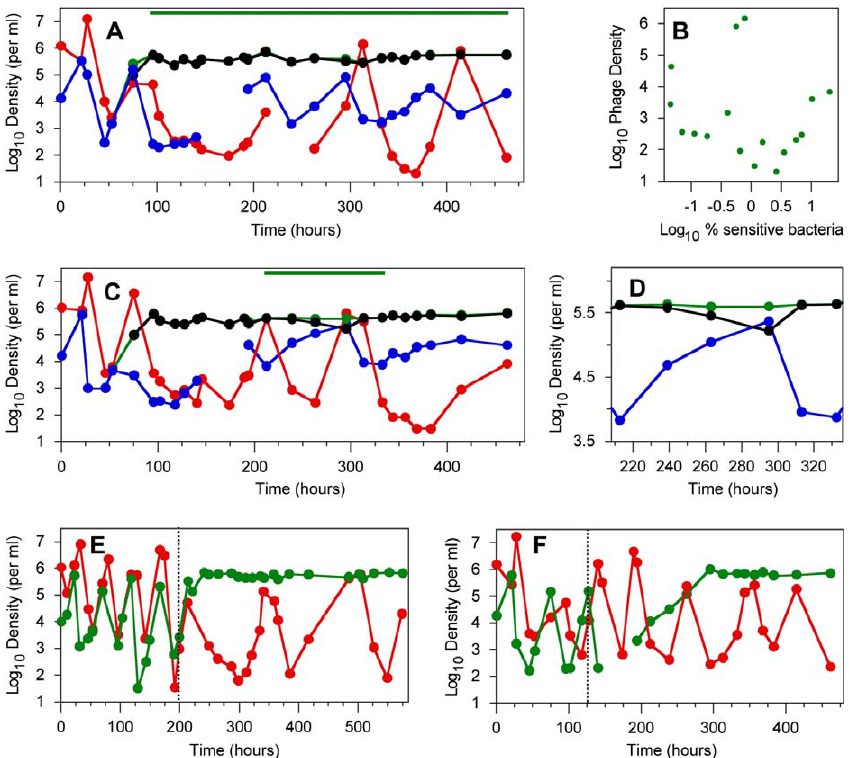
Figure 6. Experimentally Observed Cryptic Cycles in Bacteria–Phage Chemostats (A) Results from [32] showing densities of phage (red), sensitive bacteria (blue), resistant bacteria (black), and total bacteria (green, mostly hidden by black). Resistant bacteria with a neutral genetic marker were introduced ’ 75 h after the experiment was initiated with phage and sensitive bacteria. (B) The relationship between phage density and the fraction of sensitive bacteria, plotted for the time period indicated by the dark green line at the top of (A), which omits the period before the introduction and transient increase of the resistant strain. (C) Results [32] plotted as in (A). (D) A ‘‘ blowup ’’ of the time period indicated by the dark green line at the top of (C), when the sensitive strain increased greatly during a period of low phage density. These data show density compensation, with total bacterial density remaining nearly constant due to opposing changes in the abundance of the two bacterial strains. (E and F) Two experiments where the spontaneous appearance of a second, resistant, bacterial type led to a change in dynamics: stabilization of total bacteria, and longer cycle periods in the phage. In both panels E and F, the dashed vertical lines show when the resistant strain was first detected; because the resistant type did not have a neutral marker, the separate abundances of resistant and sensitive bacteria could not be tracked accurately once the resistant strain became numerically dominant. The data in panel E are from ([43], Figure 3B), data in F are from [32]